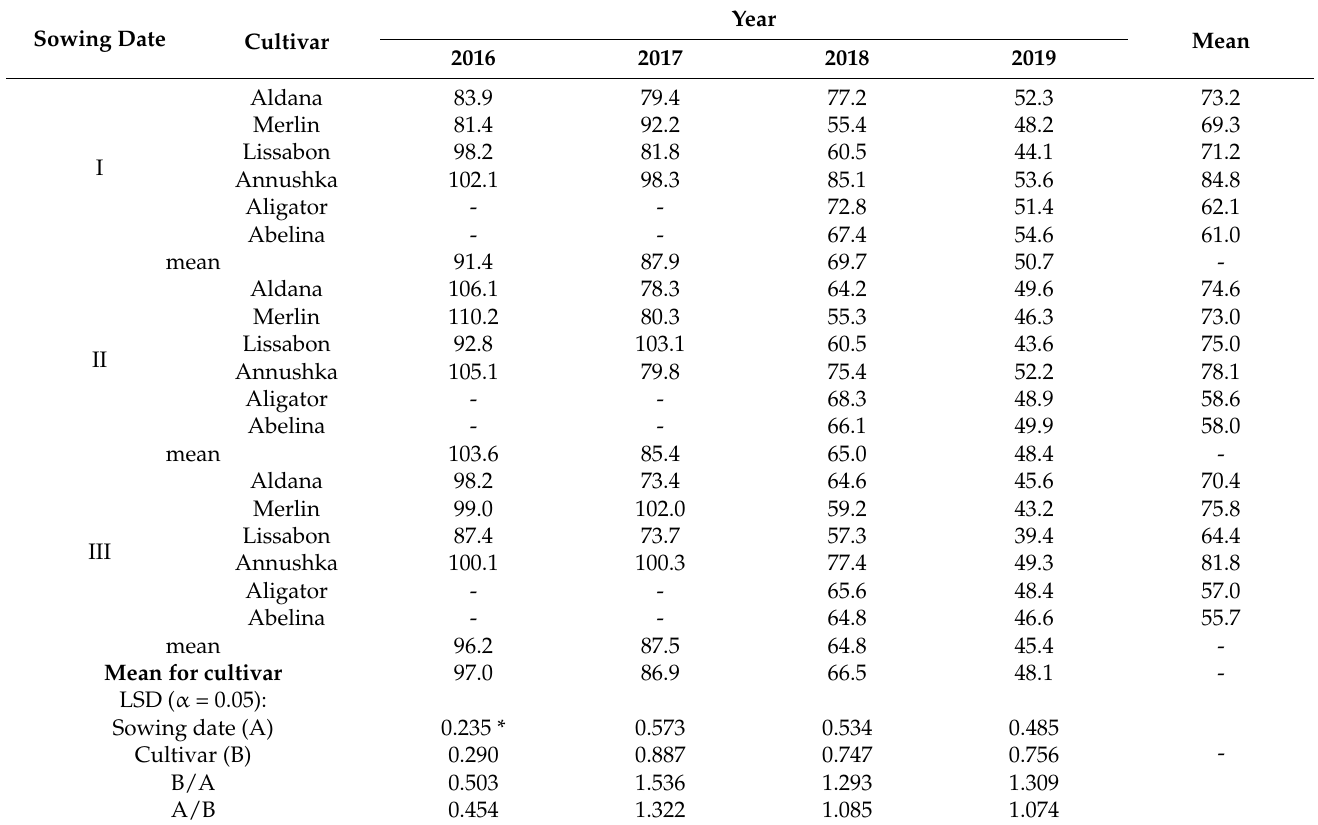
Table 7. Crude fibre content in soybean seeds depending on cultivar and sowing date (g kg − 1